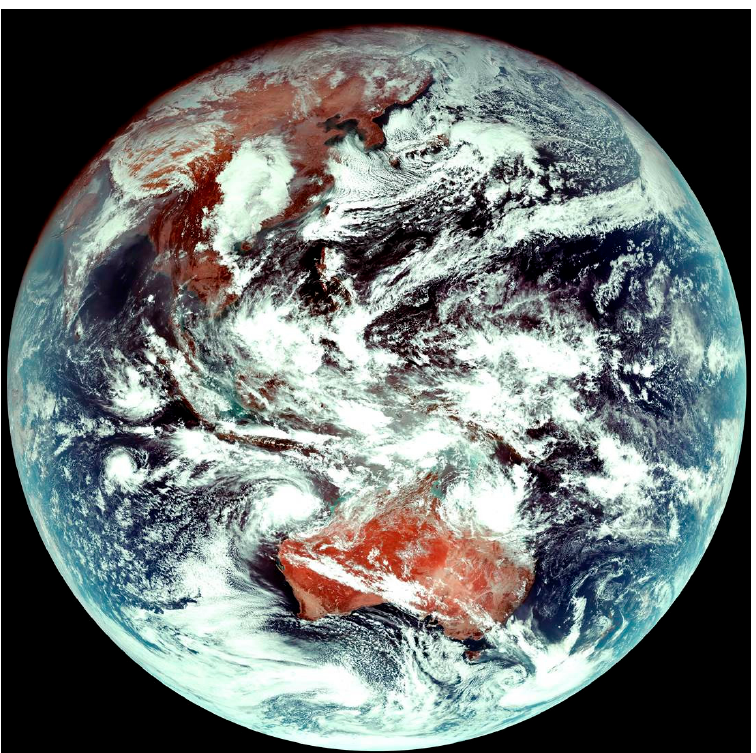
Figure 3. First true-color composite image from GK2A at 03:10 Coordinated Universal Time (UTC) on 25 January 2019.